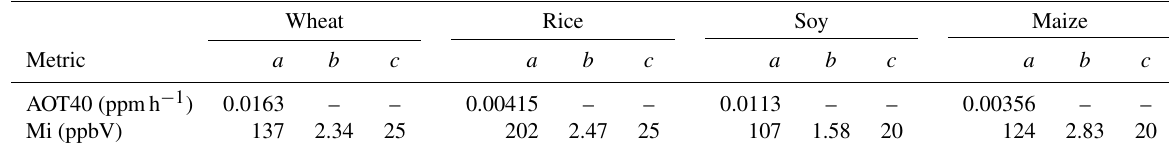
Table 3. Overview of air quality indices used to evaluate crop yield losses. The a , b , and c coefficients refer to the exposure-response equations given in Eqs. (5) and (6). Sources include Van Dingenen et al. (2009), Mills et al. (2007), and Wang and Mauzerall (2004). Wheat Rice Soy Maize Metric a b c a b c a b c a b c AOT40 (ppmh − 1 ) 0.0163 – – 0.00415 – 0.0113 Mi (ppbV)